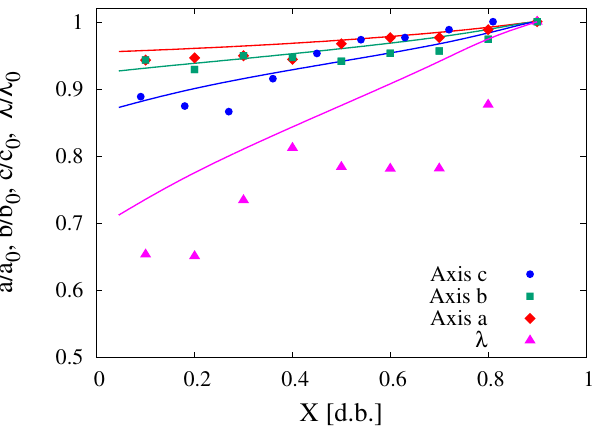
Figure 14. Rescaled lengths of the three principal axes and shell thickness vs. total moisture content X = X core + X shell (kg/kg db) for cocoa beans of data set (2), T = 60 ◦ C, v = 0.6 m/s. Comparison between experimental data and model predictions with D = 3.12 × 10 − 10 m 2 /s, Bi m = 12.87, α 0 =